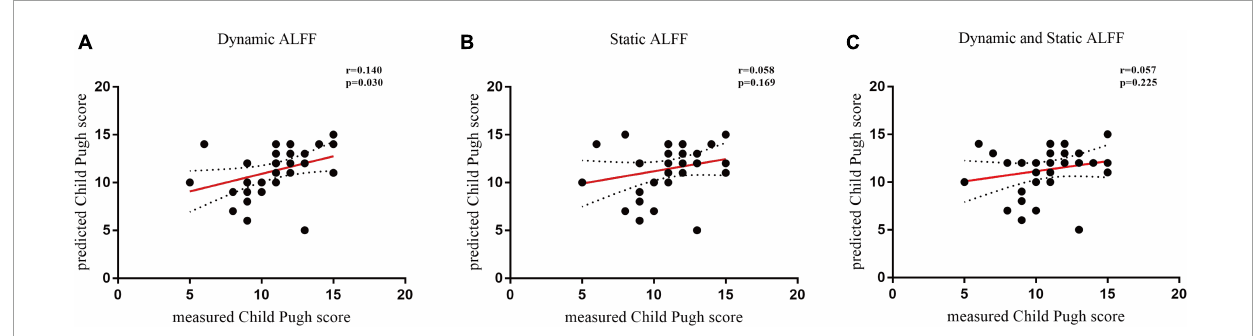
FIGURE4 Temporal variability of dynamic amplitude of low-frequency fluctuation (dALFF) predicts Child–Pugh scores. (A) The use of dynamic ALFF to predict the Child–Pugh scores (r = 0.140, p = 0.030). (B) The use of static amplitude of low-frequency fluctuation (sALFF) to predict the Child–Pugh score (r = 0.058, p = 0.169). (C) The use of combination of dALFF and sALFF features to predict the Child–Pugh score (r = 0.057, p = 0.225). Filled circles represent data included in this correlation analysis, while open circles indicate data excluded from this analysis. Solid and dashed red lines represent the best-fit line and 95% confidence intervals of Pearson’s correlation analysis, respectively. ALFF, amplitude of low-frequency